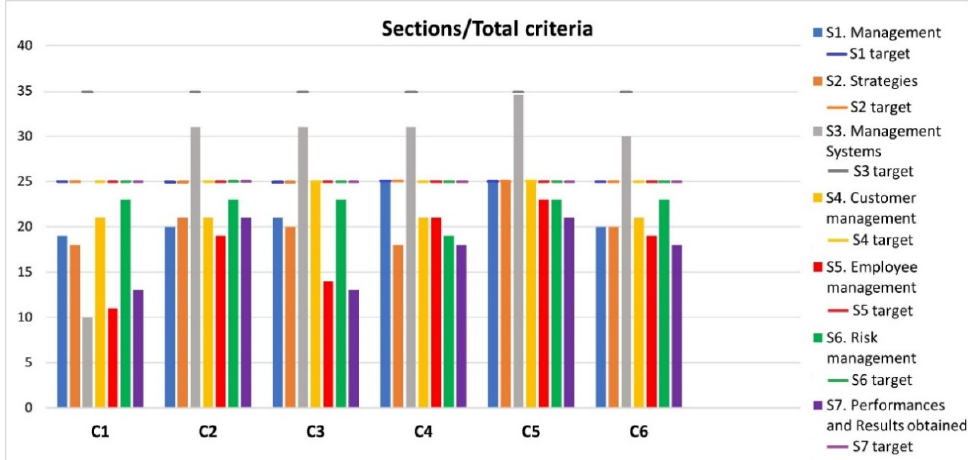
Figure 6. Total scores obtained in each section by the enterprises.